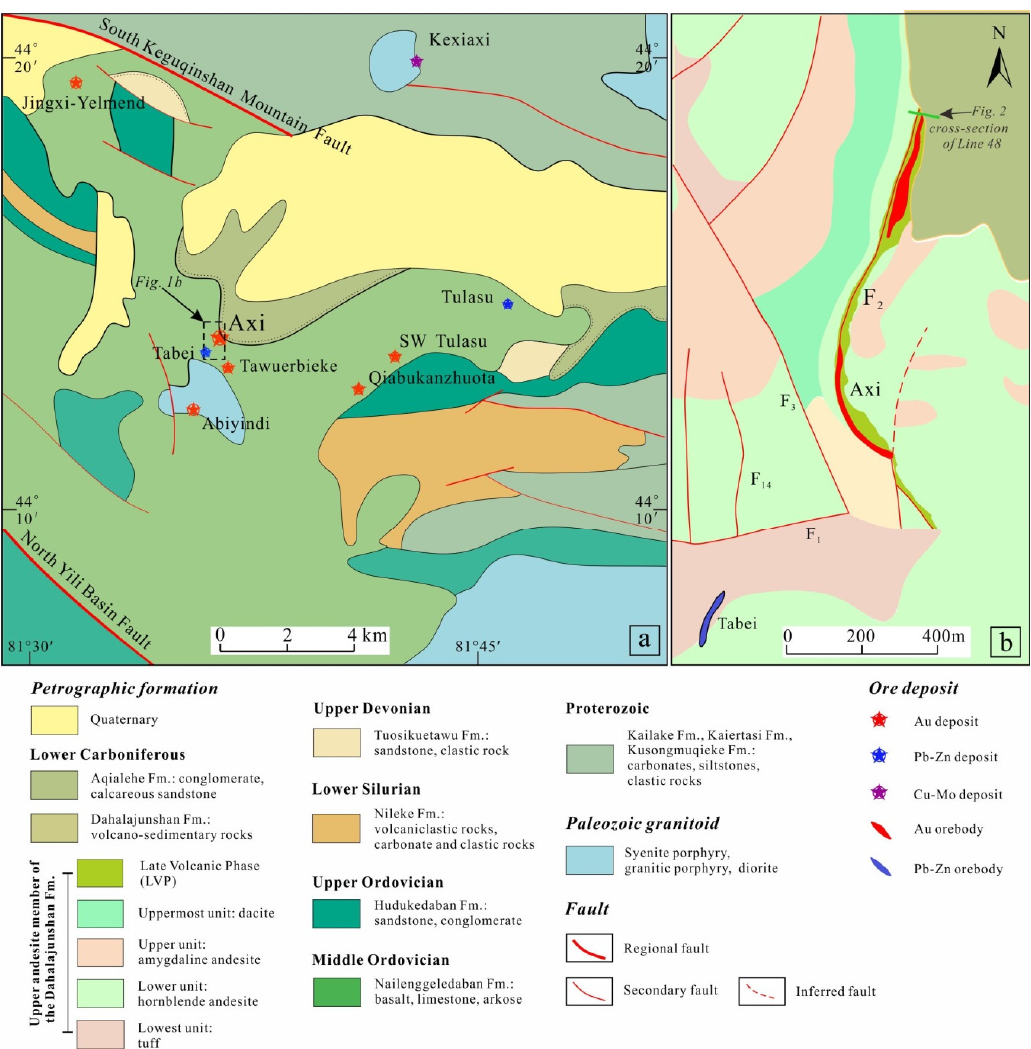
Figure 1. ( a ) Geological map of the Tulasu basin showing the locations of porphyry and epithermal deposits. ( b ) Geological map of the Axi district. Both subfigures are based on Liu et al. [35].